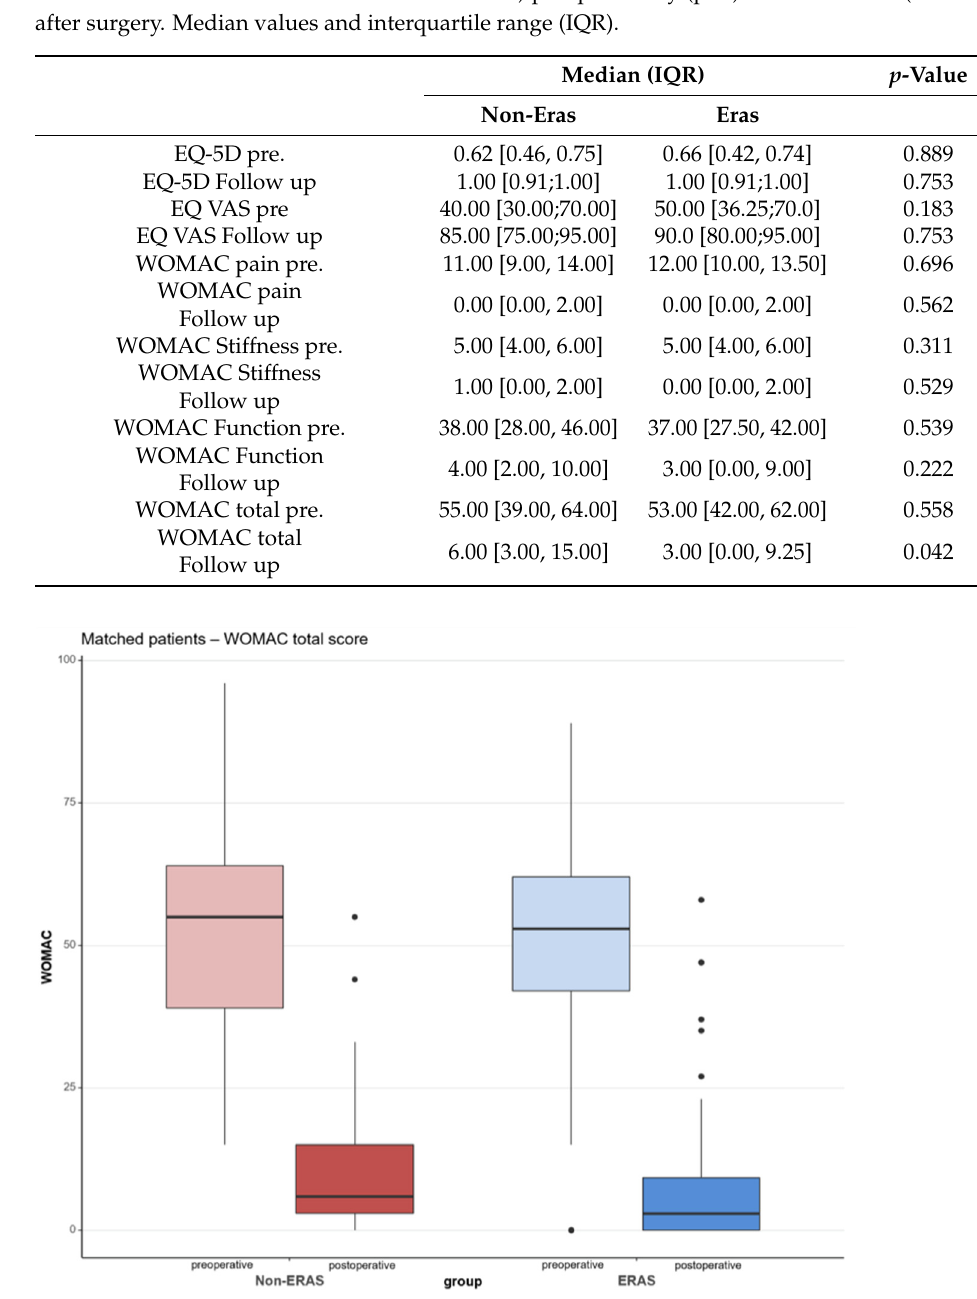
Table 3. PROM scores of Euroqol (EQ-5D), Euroqol VAS (EQ VAS) and WOMAC (Western Ontario and McMaster Universities Osteoarthritis Index) preoperatively (pre.) and 12 months (follow up) after surgery. Median values and interquartile range (IQR).